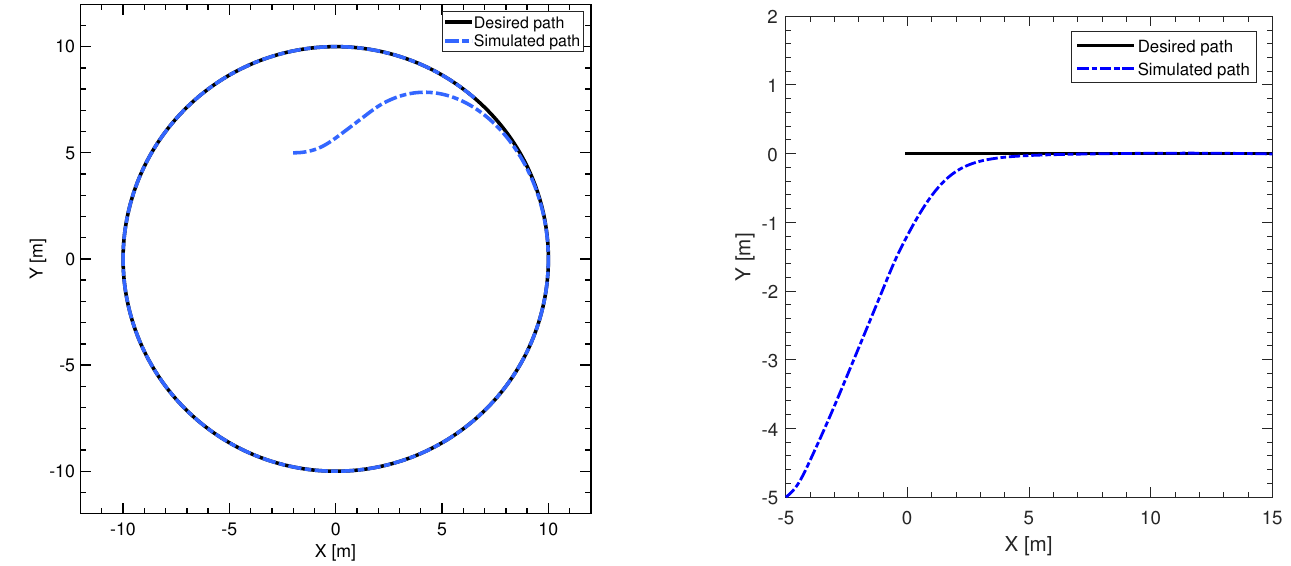
Figure 9. Trajectory following tests: circular ( left ) and straight ( right ) path.